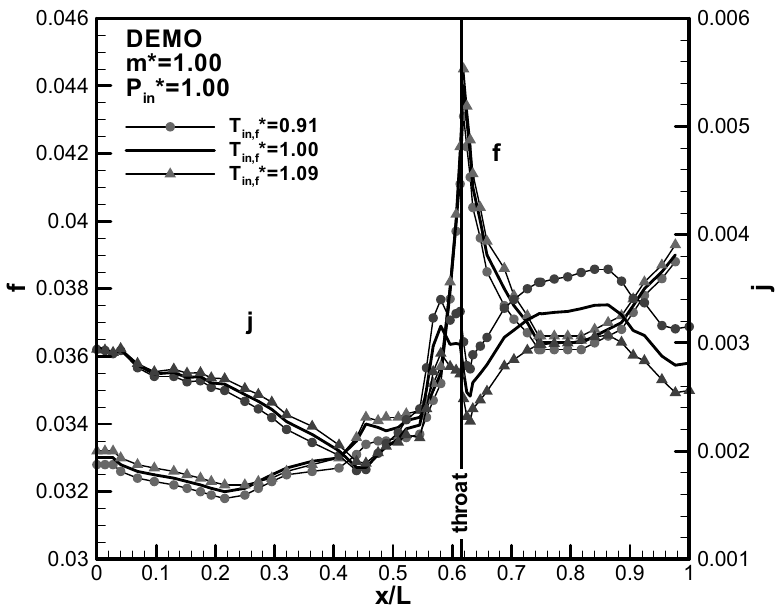
Figure 13. Axial profiles of friction factor and Colburn number, considering different values of inlet fluid temperature (runs 1-3).